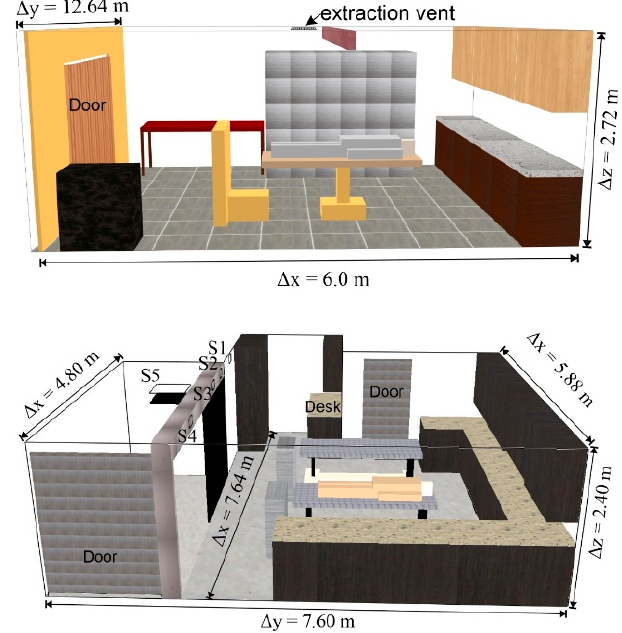
Figure 1. Schematic representation of labs: A ( top ), B ( middle ), and C ( bottom ) (diffusers: S1–S6).